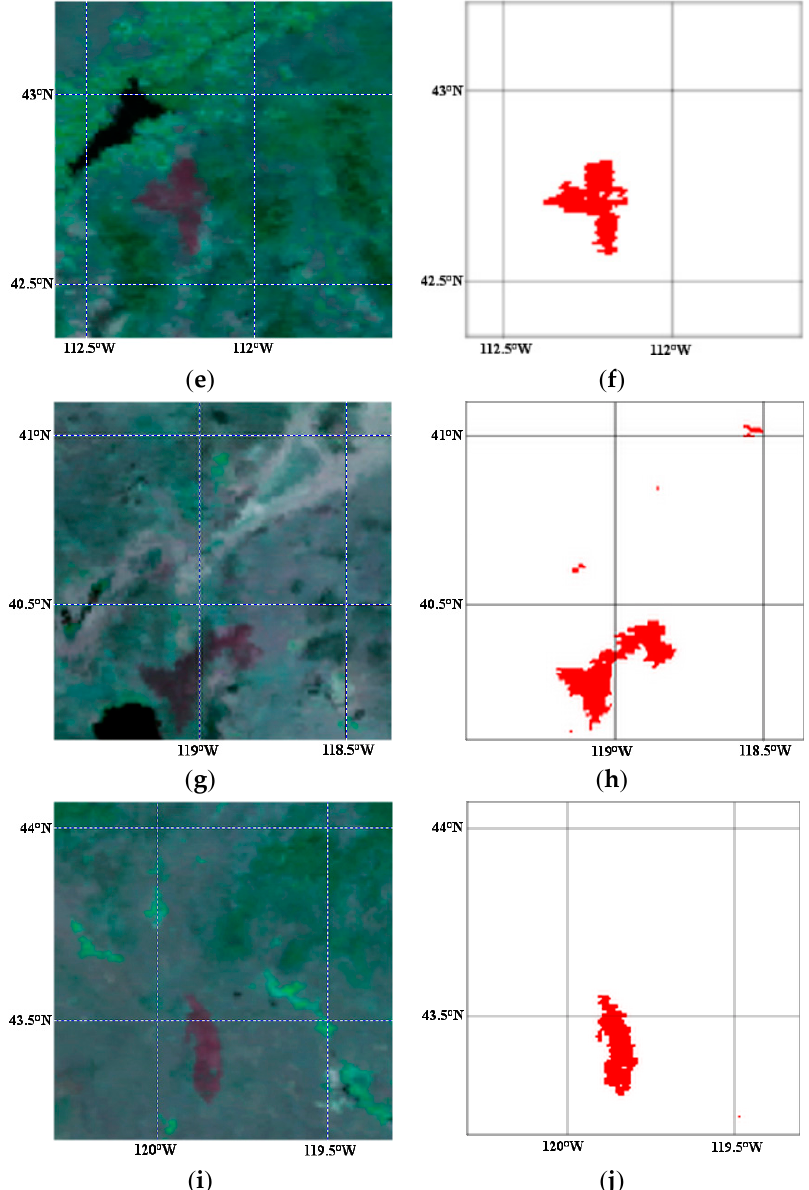
Figure 12. ( a ), ( c ), ( e ), ( g ), and ( i ) are the false-color composition RGB images of MODIS bands 7, 5 and 6 in Hot Pot Fire, Range 12 Fire, Powerline Fire, Tohakum 2 Fire, and Cinder Butte Fire, respectively; ( b ), ( d ), ( f ), ( h ) and ( j ) are the proposed method’s detection results of the burned area for ( a ), ( c ), ( e ), ( g ) and ( i ), respectively.